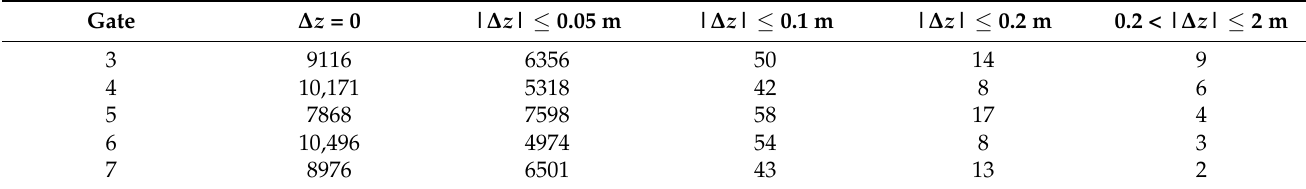
Table 6. Water level changes in each